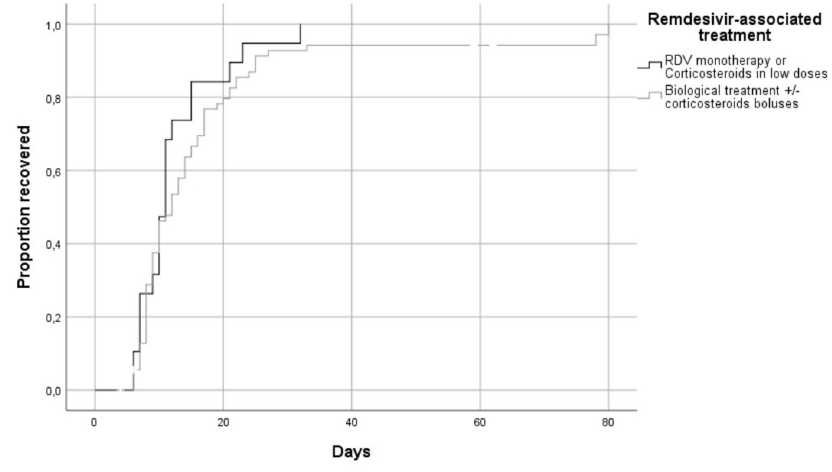
Fig 2. Kaplan-Meier estimates of cumulative recoveries according to the remdesivir-associated treatment.